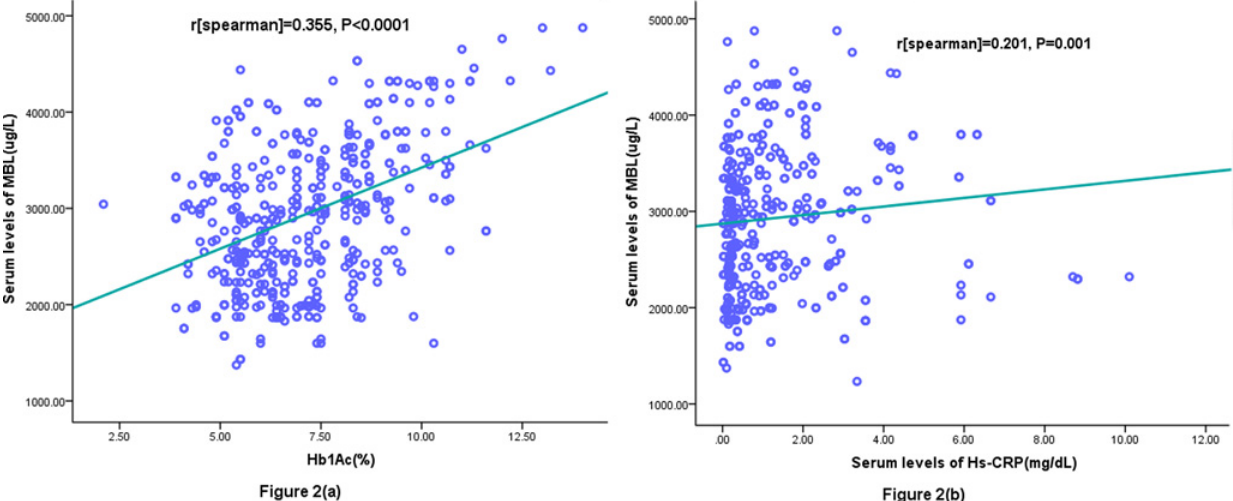
Fig 2. Correlation between the serum MBL levels and other factors (a) Correlation between the serum MBL levels and HbA1c; (b) Correlation between the serum MBL levels and Hs-CRP.